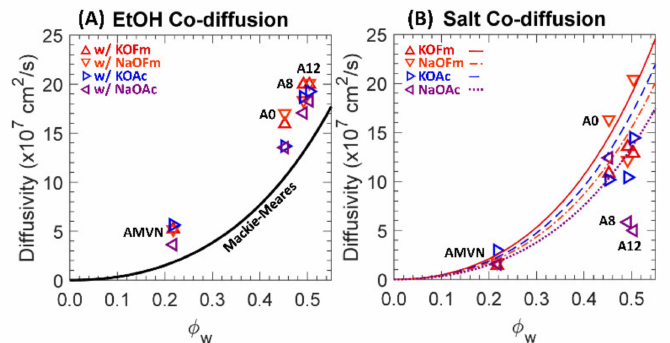
Figure 10. ( A ) Diffusivities to EtOH, , in co-diffusion with KOFm ( (cid:52) , red), NaOFm ( (cid:53) , orange), (cid:35) KOAc ( (cid:46) , blue) and NaOAc ( (cid:47) , purple). The solid line is the Mackie–Meares’ fit. ( B ) Diffusivities to KOFm ( (cid:52) , red), NaOFm ( (cid:53) , orange), KOAc ( (cid:46) , blue) and NaOAc ( (cid:47) , purple) in co-diffusion with EtOH. The lines are the Mackie–Meares’ fits, KOFm (solid line, red), NaOFm (dot-dashed, orange), KOAc (dashed, blue) and NaOAc (dotted,